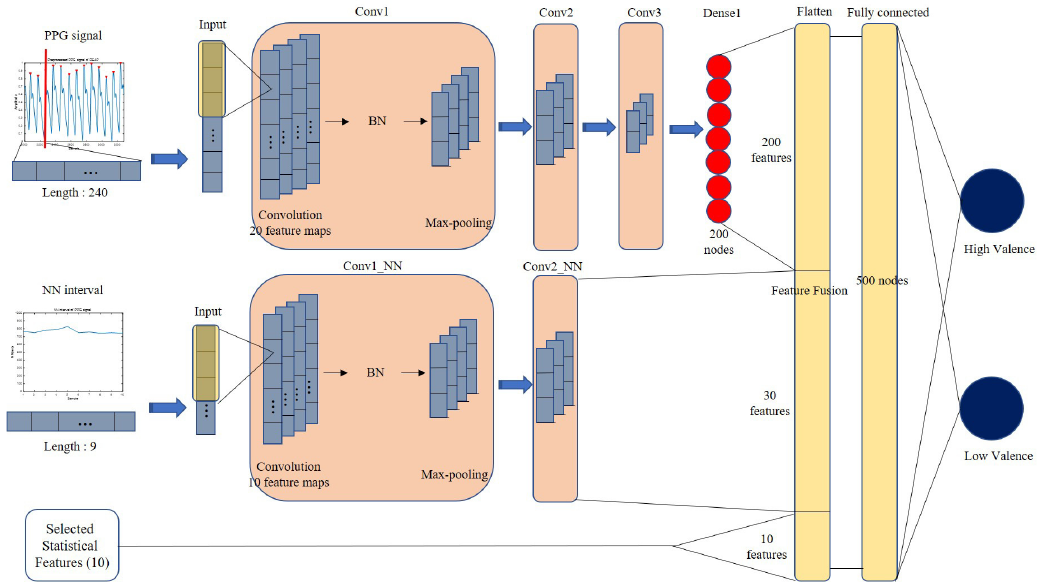
Figure 8. Overall architecture of emotion